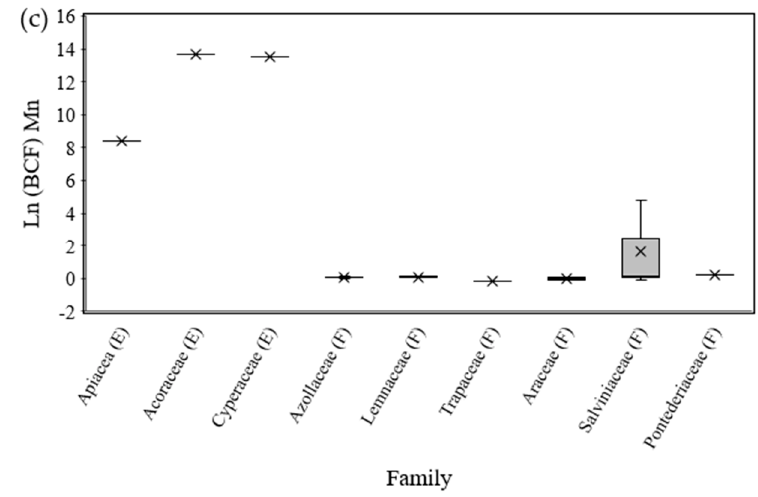
Figure 1. Boxplot of bioconcentration factors (BCF), expressed as ln, for iron (Fe) ( a ), copper (Cu) ( b ) and manganese (Mn) ( c ). The symbol “X” represents the mean. (E) Emergent families of macrophyte; (F) floating families of macrophyte; (S) submerged families of macrophyte.